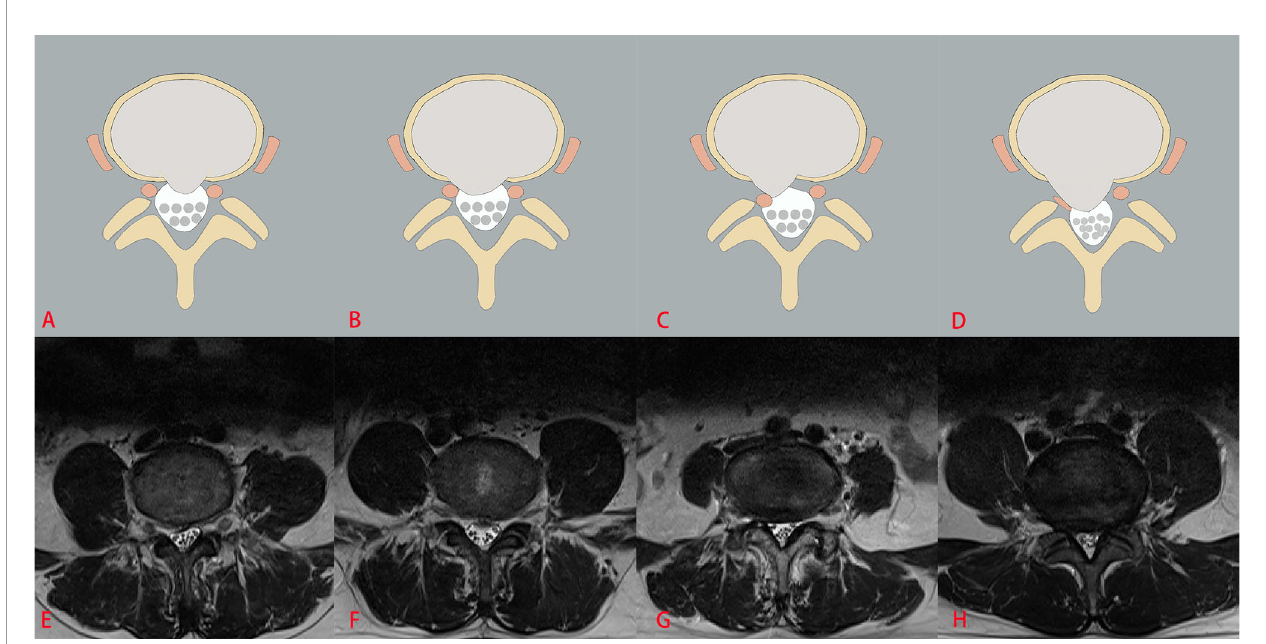
FIGURE 4 | The classi fi cation system of lumbar nerve root compromise (LNRC). The top column is a schematic diagram of four grades with LNRC, and the bottom column is the corresponding axial T2W TSE images of four grades with LNRC. Grade 0 (A, E) No compromise of the nerve root is seen (normal). There is no evident contact of disk material with the nerve root and the epidural fat layer between the nerve root and the disc material is preserved. Grade 1 (B, F) There is visible contact of disc material with the nerve root and the normal epidural fat layer between the two is not evident (contact). The nerve root has a normal position and there is no dorsal deviation. Grade 2 (C, G) The nerve root is displaced dorsally by disc material (deviation). Grade 3 (D, H) The nerve root is compressed between disc material and the wall of the spinal canal; it may appear fl attened or be indistinguishable from disc material (compression).